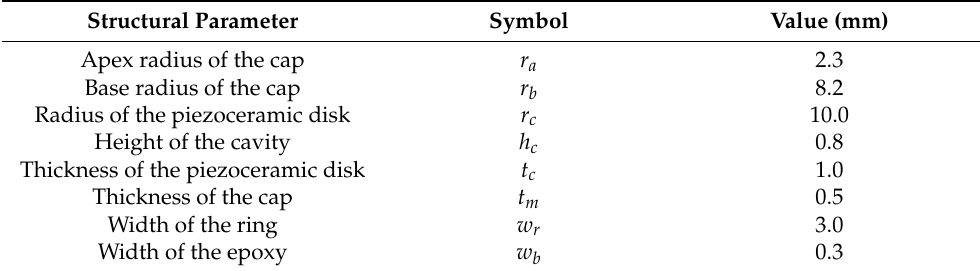
Figure 1. 2D axisymmetric finite-element analysis (FEA) model of the cymbal transducer. Table 1. Structural parameters and dimensions of the cymbal transducer.